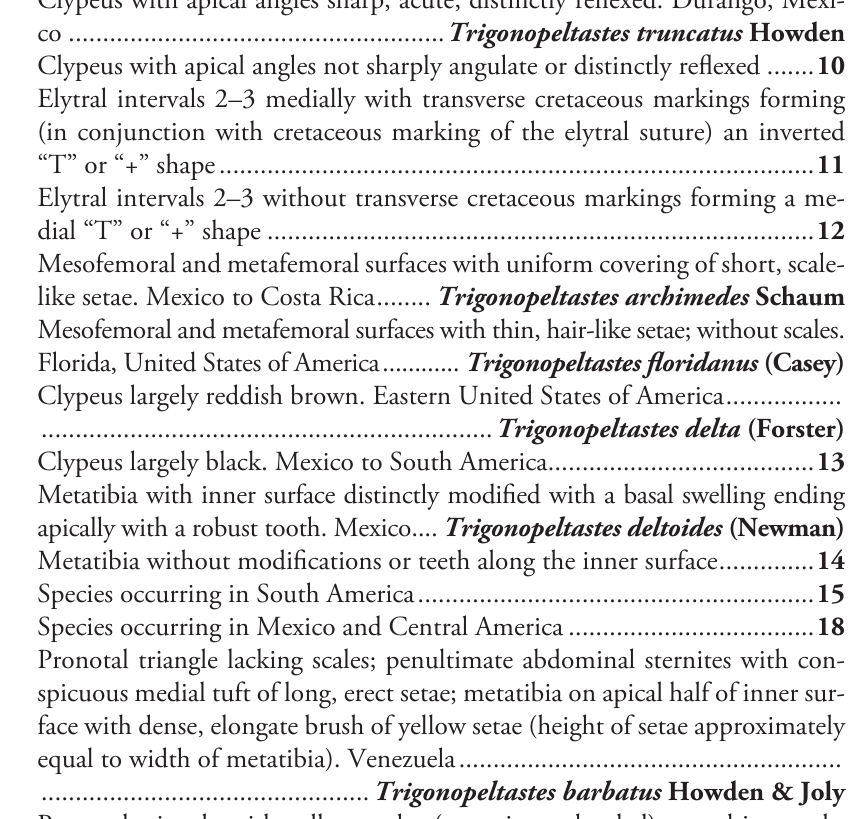
Pronotal triangle lacking scales; penultimate abdominal sternites with con- spicuous medial tuft of long, erect setae; metatibia on apical half of inner sur- face with dense, elongate brush of yellow setae (height of setae approximately